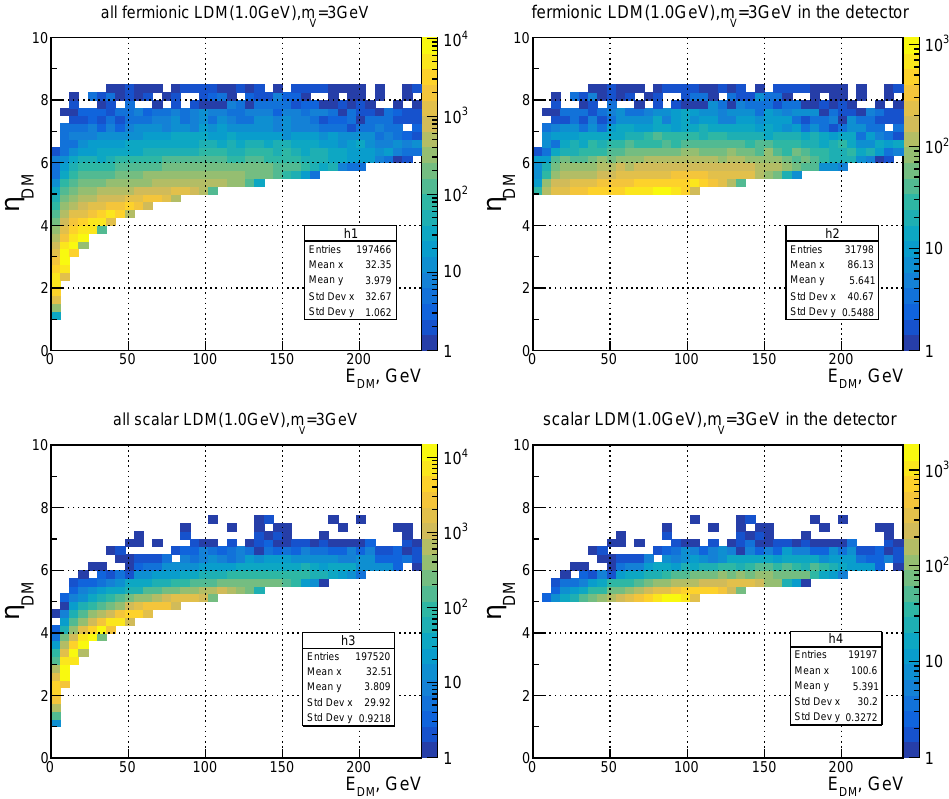
Figure 7. Pseudorapidity η and energy E distributions of simulated LDM particles reaching the SND